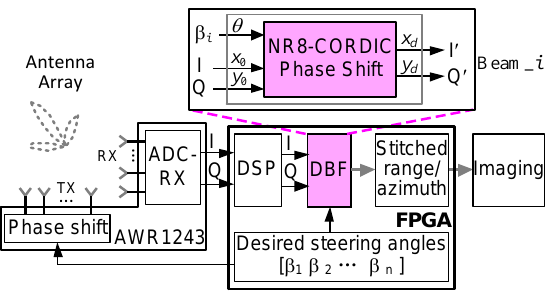
Figure 8. The diagram of digital beamforming (DBF) mode for the MIMO millimeter wave radar.